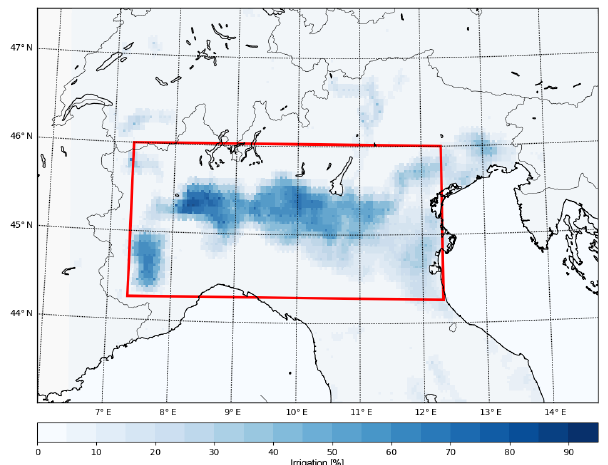
Figure 3. Percentage of irrigated area after regridding for the Po Valley. The red box highlights the averaging area used in this